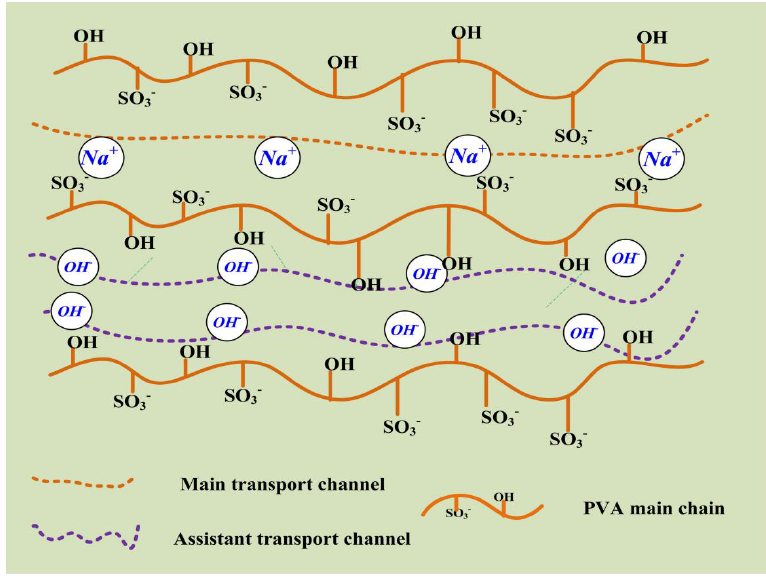
Figure 5. Mimetic transport process of Na + and OH − .